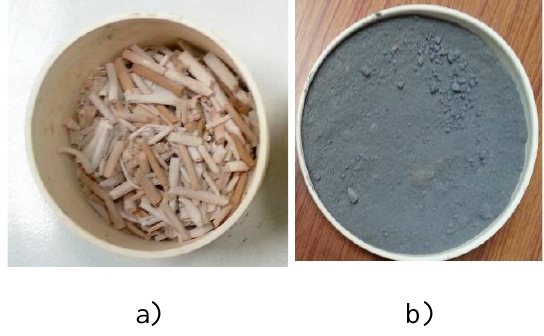
Figure 1. Water hyacinth stem ash: a) after muffle burning, b) after grinding and sieving